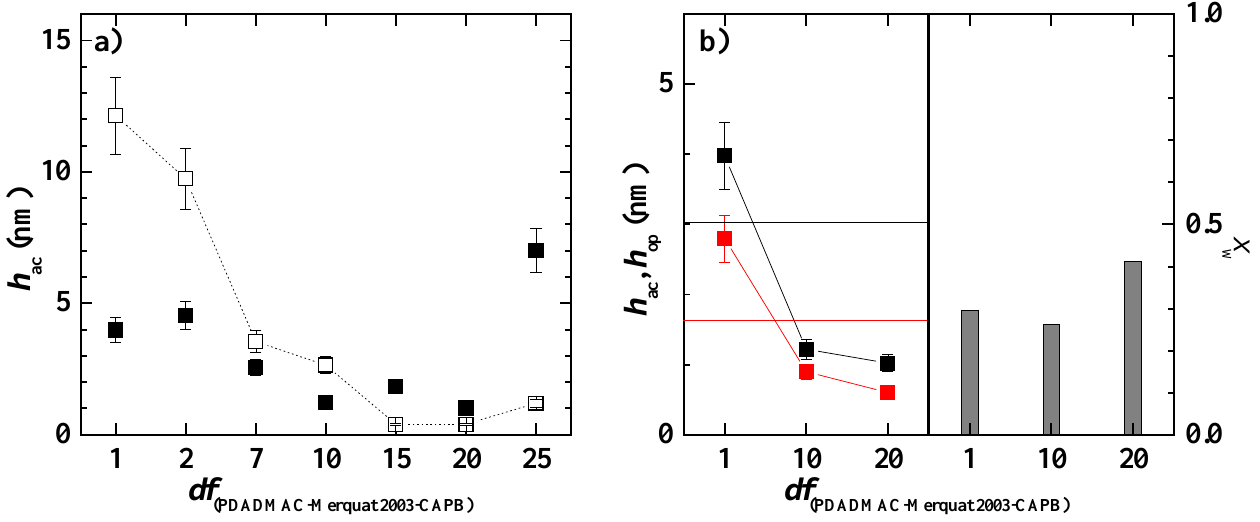
Figure 11. ( a ) Surfactant–polymer concentration phase diagrams for the combination of PDADMAC, Merquat 2003, and CAPB. The symbols correspond to one-phase mixtures and the discontinuous solid line corresponds to the dilution of a hypothetical mixture with S/P = 1. The value of the dilution factors ( df ) corresponding to the maximum df explored is also indicated. Furthermore, the S/P value corresponding to the dilution line of the sample is also included. Notice that polymer concentration is referring to the total concentration of cationic monomers, including those corresponding to both polymers. ( b ) Image showing the dilution process (from left to right) of the pseudo-ternary polymer–CAPB mixtures with the same composition of components as in Table 2.